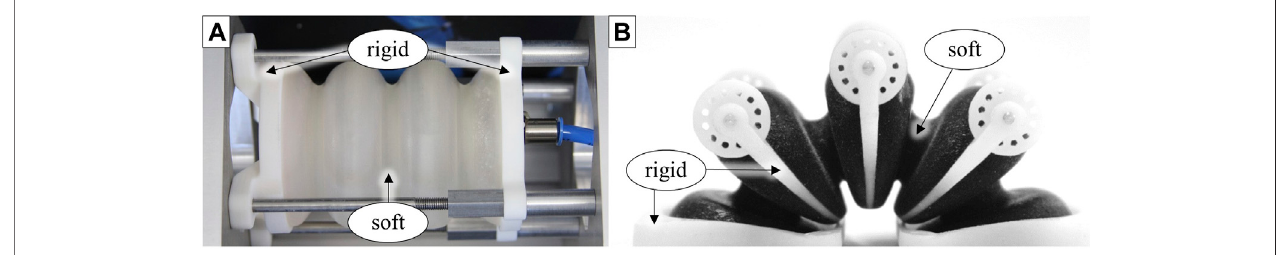
FIGURE2| Bellowsactuatorsmanufacturedby3Dinkjetprintingofthermosettingsoftand rigidmaterials. (A) :Linearactuator forinvestigatingtheeffectsofshape and material variations on structural behavior and fatigue (Dämmer et al., 2019a). (B) : Rotary bellows chamber for actuation of a lightweight gripper (Dämmer et al.,